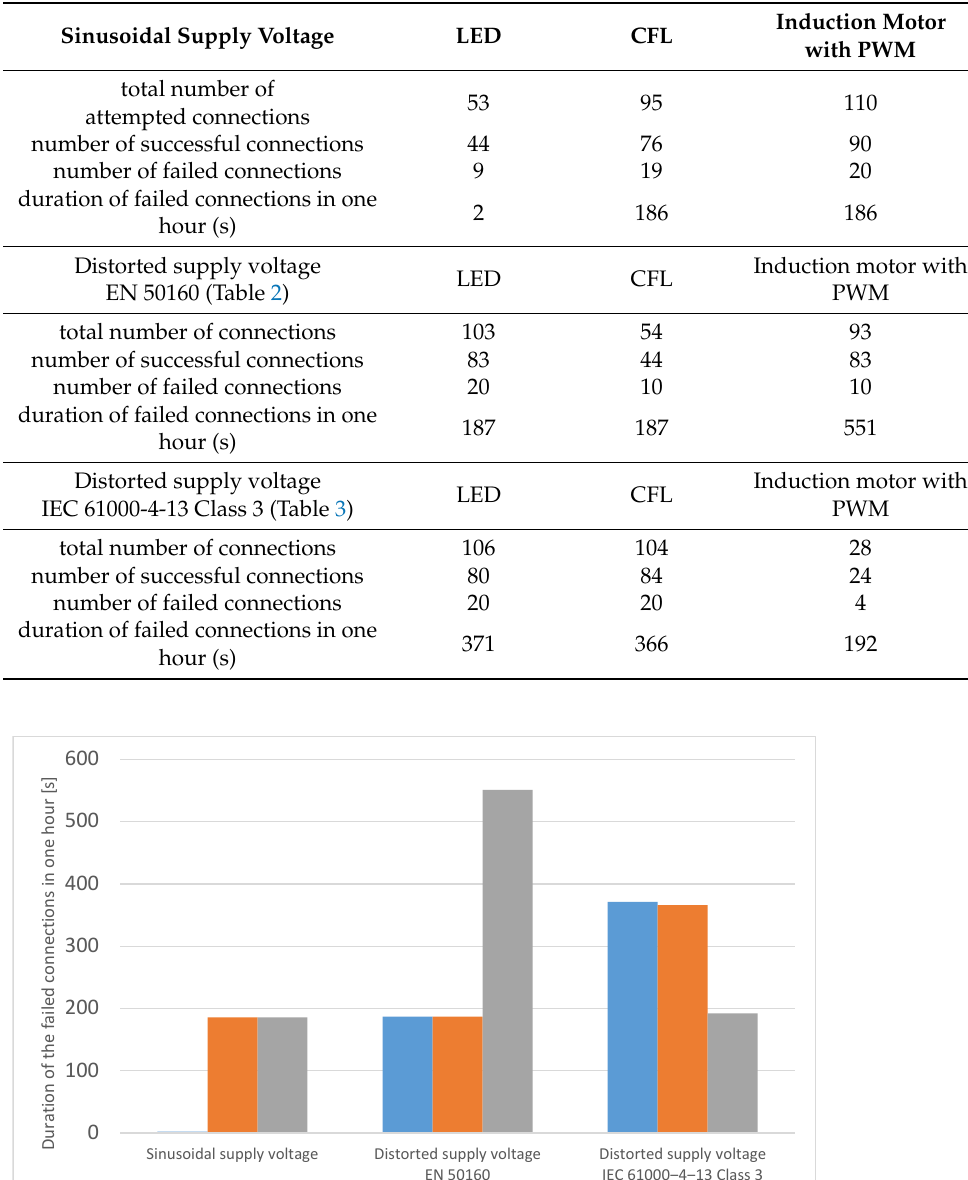
Table 5. The statistics of the transmission of the investigated PRIME PLC during the different scenarios of supply voltage distortion and variant types of loads (2 h continuous work).